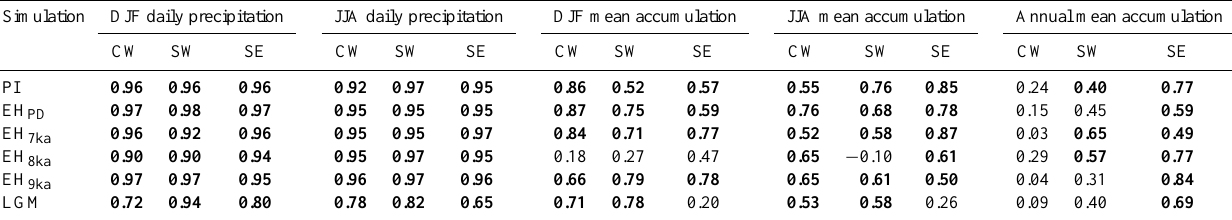
Table 3. Pattern correlation values of z500 composites for each model simulation vs. the present-day (PD) simulation. The composite patterns are derived from the accumulation (annual and seasonal mean) and precipitation (daily) time series for the CW, SW, and SE regions. The PD composite patterns used as reference to compare with are the ones shown in Fig. 10b and d (for daily precipitation variability in winter (DJF) and summer (JJA)), Fig. 8b and d (for winter and summer mean accumulation variability), and Fig. 7d–f (for annual mean accumulation variability). The domain used for the pattern correlation covers the North Atlantic area and Europe (see frame in Fig. 7). Note that bold values are significant at the 5% level using a conservative estimate derived from t -test statistics and autocorrelation applied on the North Atlantic domain